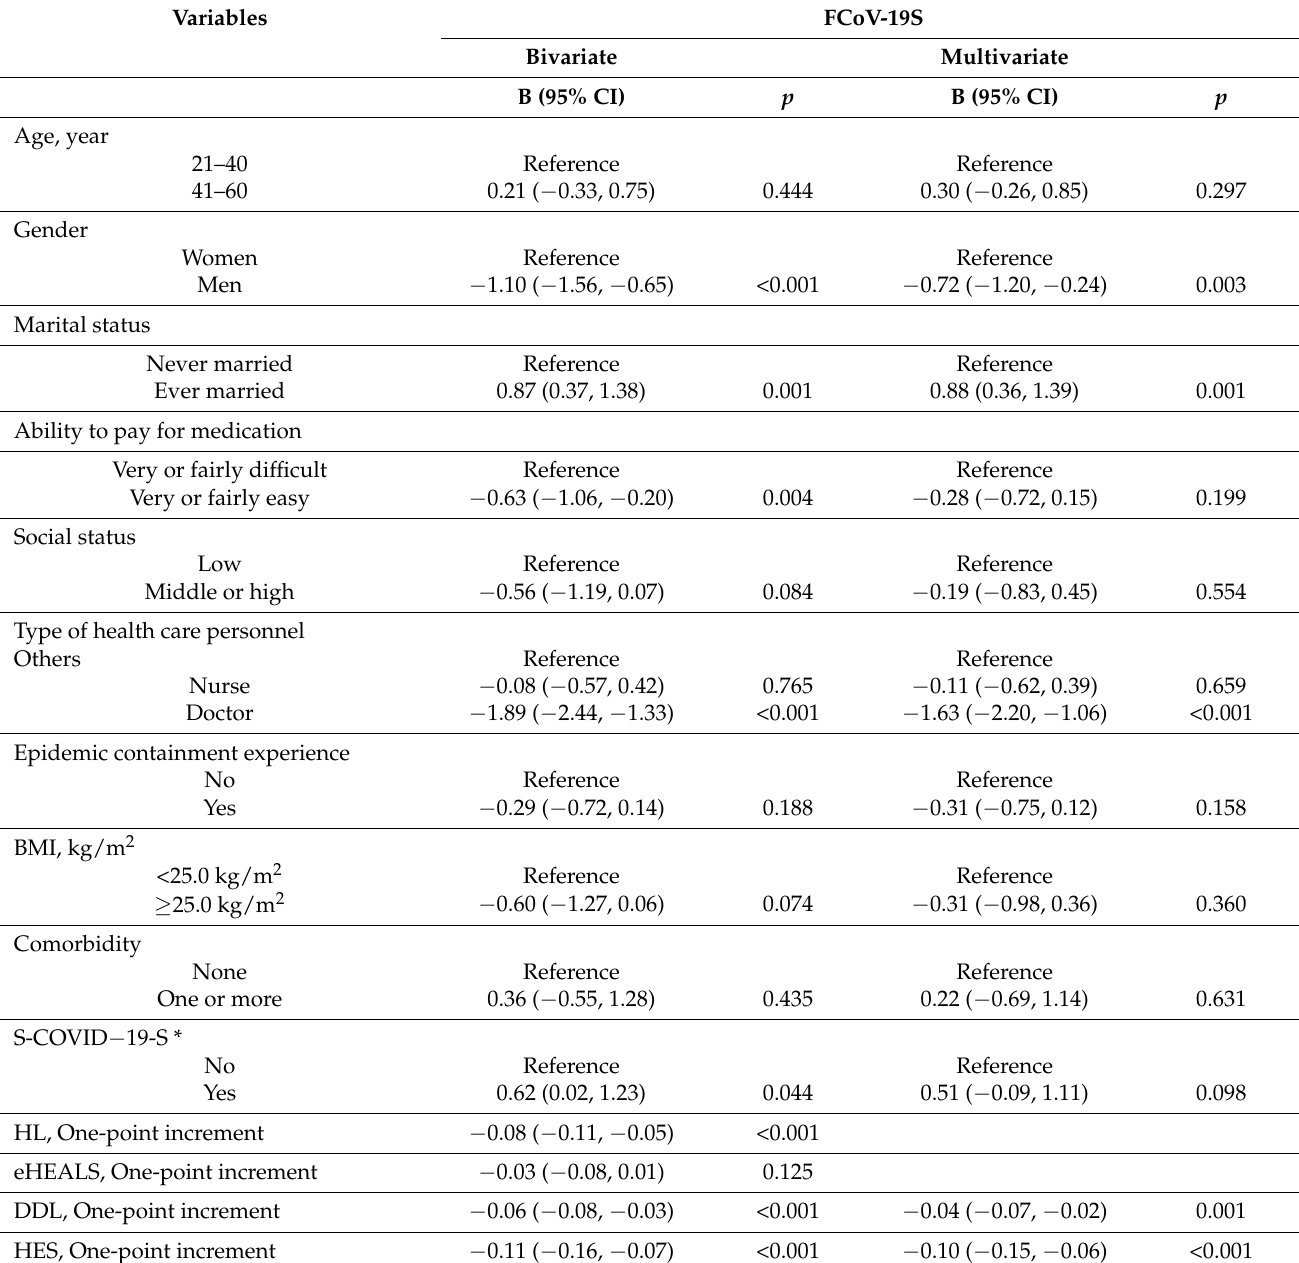
Table 2. Determinants of fear of COVID-19 among front-line health care workers via bivariate and multivariate linear regression models ( n =